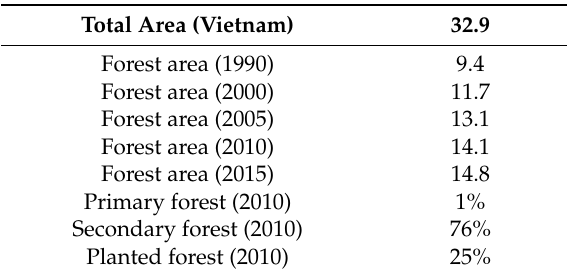
Table 1. Vietnam forest statistics [3,4]. Area values are in millions